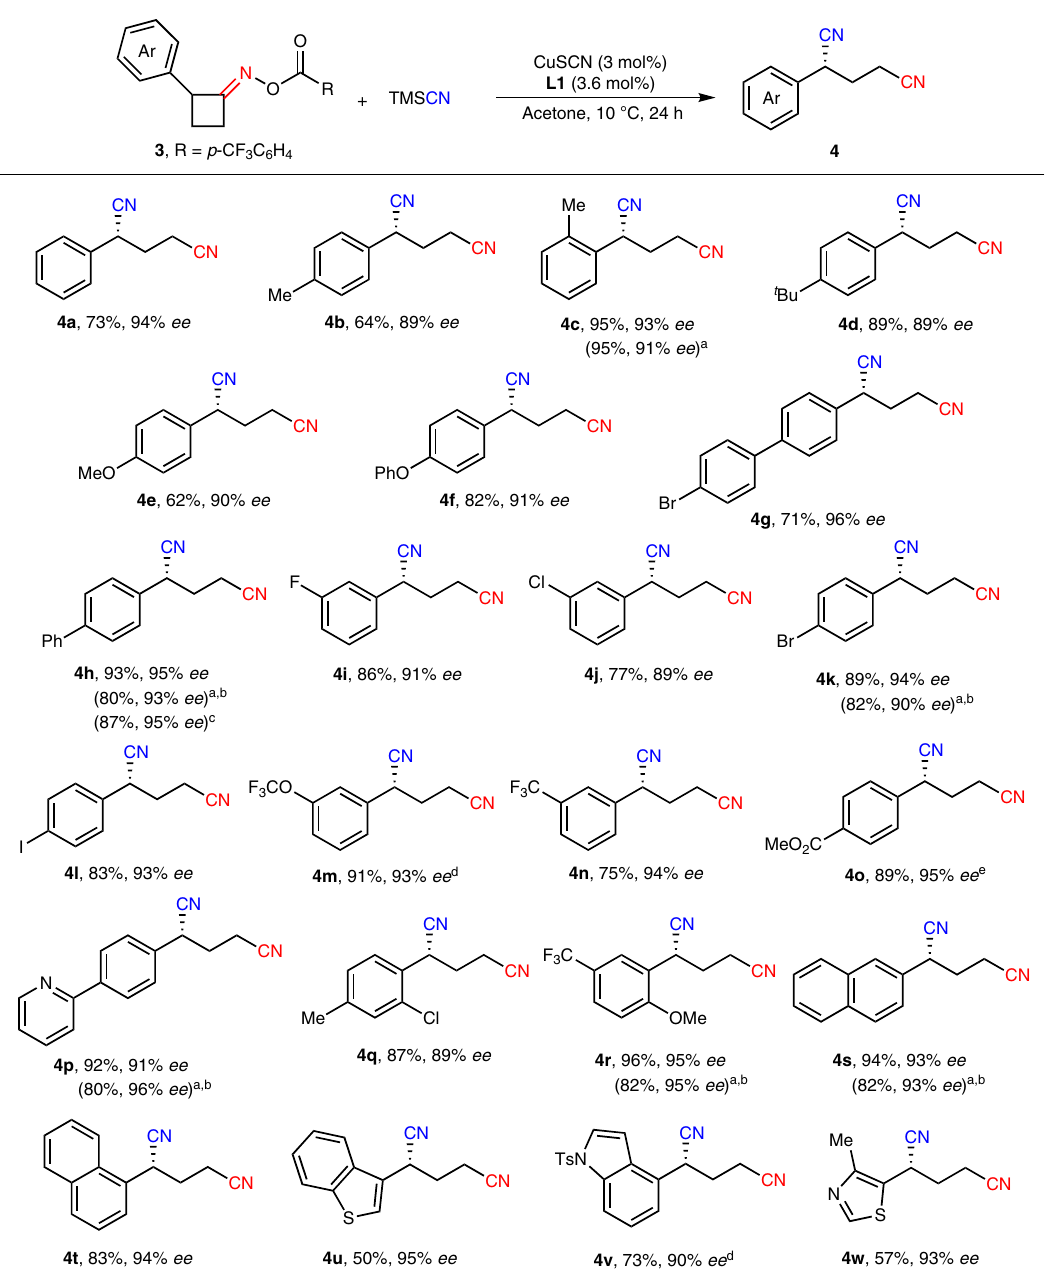
Fig. 3 Substrate scope of the cyclobutanone oxime esters 3 . Reaction conditions: 3 (0.10mmol), TMSCN (1.5 equiv), CuSCN (3 mol%), L1 (3.6 mol%) in acetone (1.0 mL) at 10 °C for 24 h. a CuSCN (1 mol%), L1 (1.2 mol%). b 48 h. c 1.0 mmol scale. d CuSCN (5 mol%), L1 (6 mol%). e ee of the crude